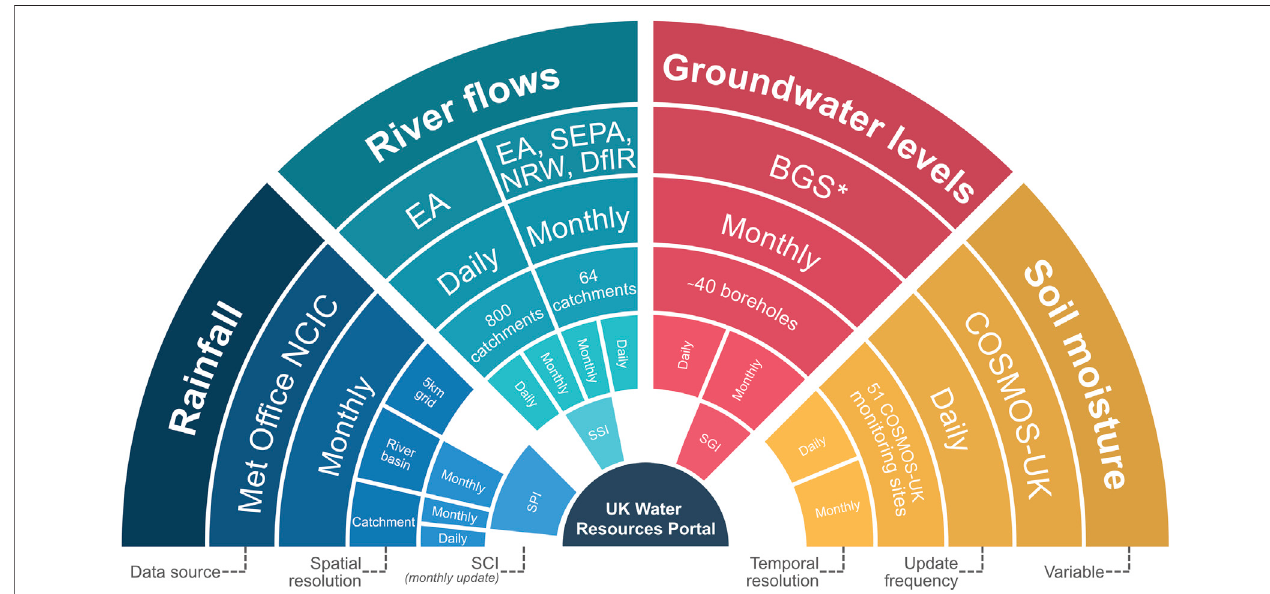
FIGURE 2 | Summary of the variables and associated metadata of data available in the UK Water Resources Portal, *Note that BGS collate data in the National Groundwater Level Archive collected by the UK environmental regulators.